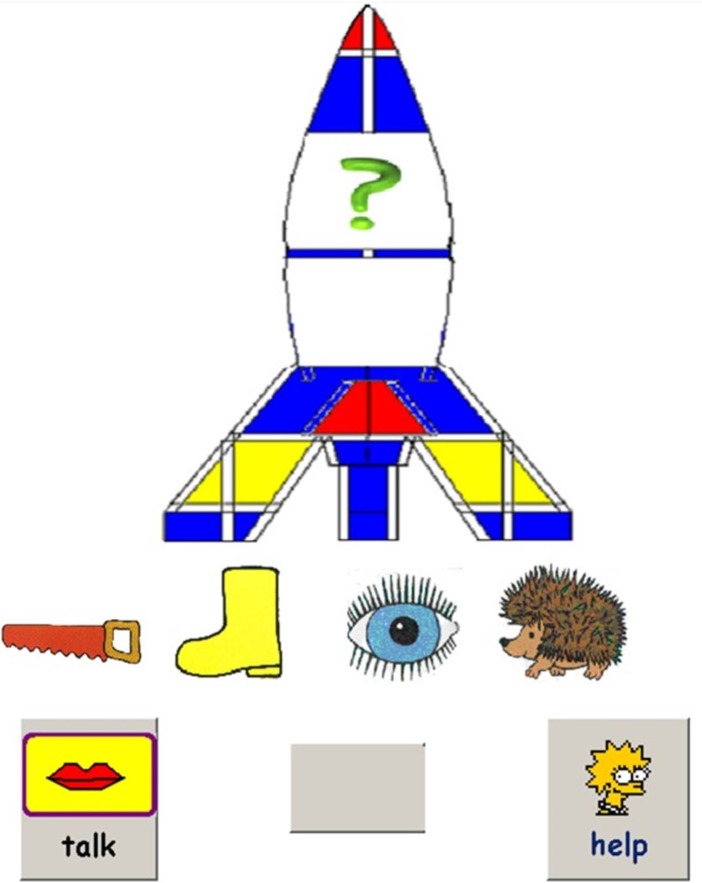
Sample screenshot from comprehension training program.The child hears a sentence such as “the hedgehog is above the boot”, and must click first on the hedgehog and then on the boot to move them into correct positions in the rocket. The question mark denotes the next position to be filled. The child can press “talk” to have the sentence repeated, and can press “help” to have visual cues added to denote which items must be moved. The format for the preposition pair “before/after” was identical except that a train was shown, and the task was to select items to fill trucks of the train in the correct horizontal order.